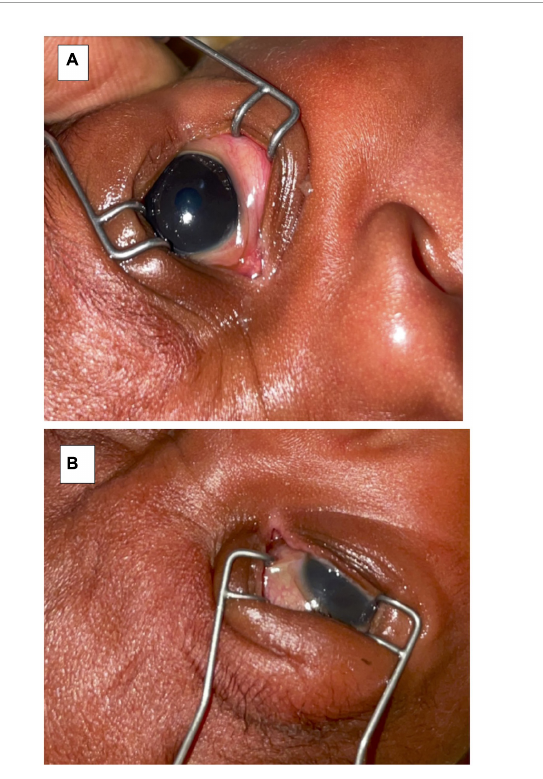
FIGURE3 Upon discharge (A) left eye examination showing a corneal scar and (B) right eye showing phthisis bulbi and